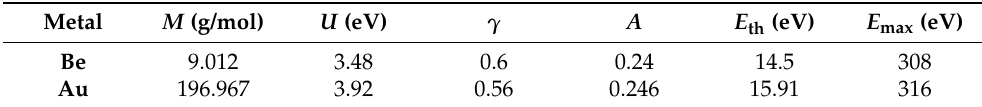
Table 2. Molar mass M , sublimation energy U , impact parameters γ and A , threshold E th = U/A , and maximum energy E max at a central elastic collision of an argon ion with an energy of 1.3 keV with an immobile metal